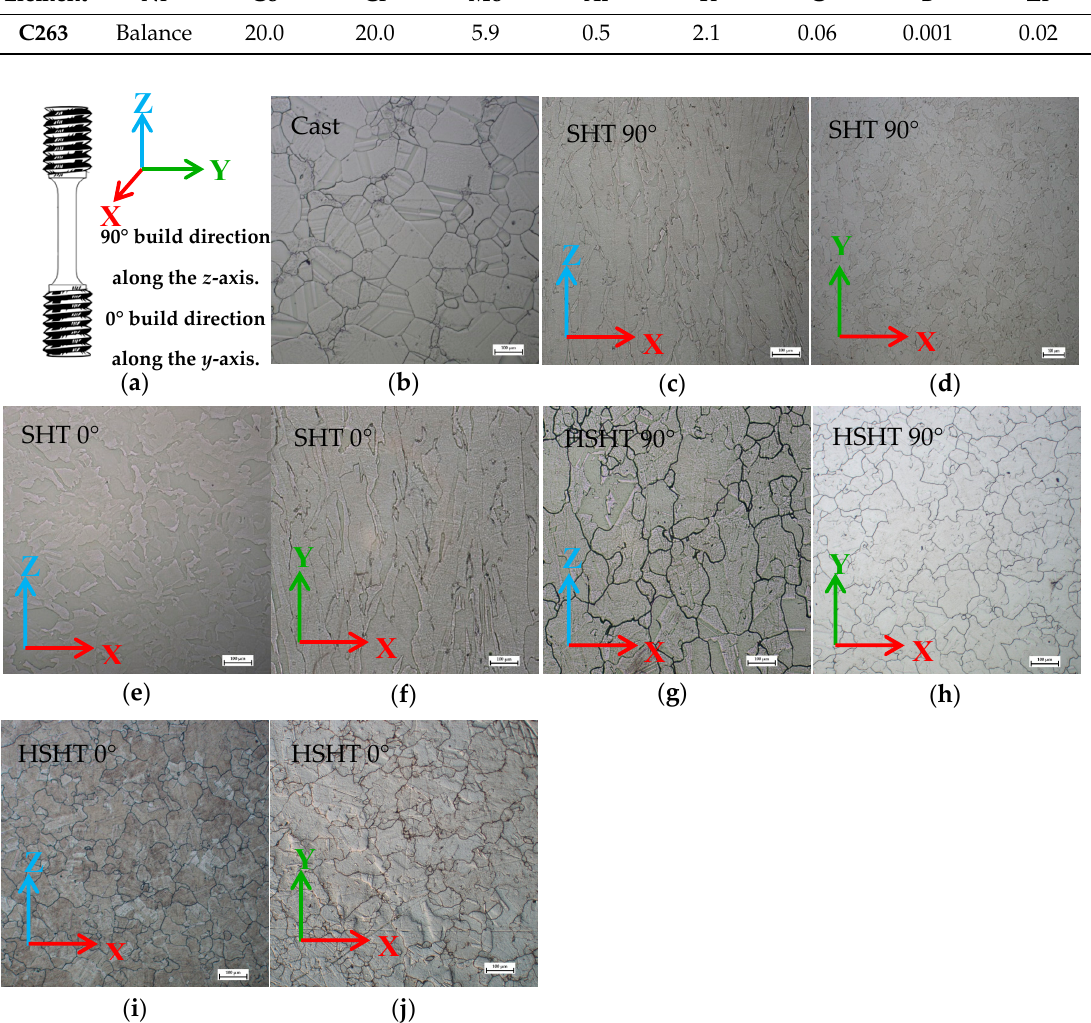
Figure 1. ( a ) schematic of build directions in relation to uniaxial specimens; ( b – j ) micrographs of C263 variant microstructures on both the x - z and x - y plane.